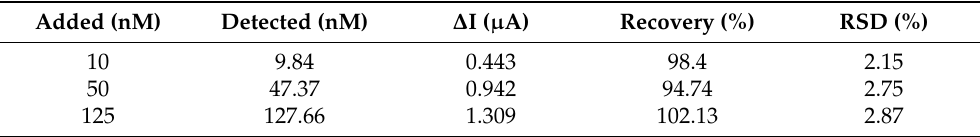
Table 2. Analytical results for microRNA-21 detection in (spiked) diluted (20 × ) human serum sample using the fabricated electrochemical DNA biosensor (n =